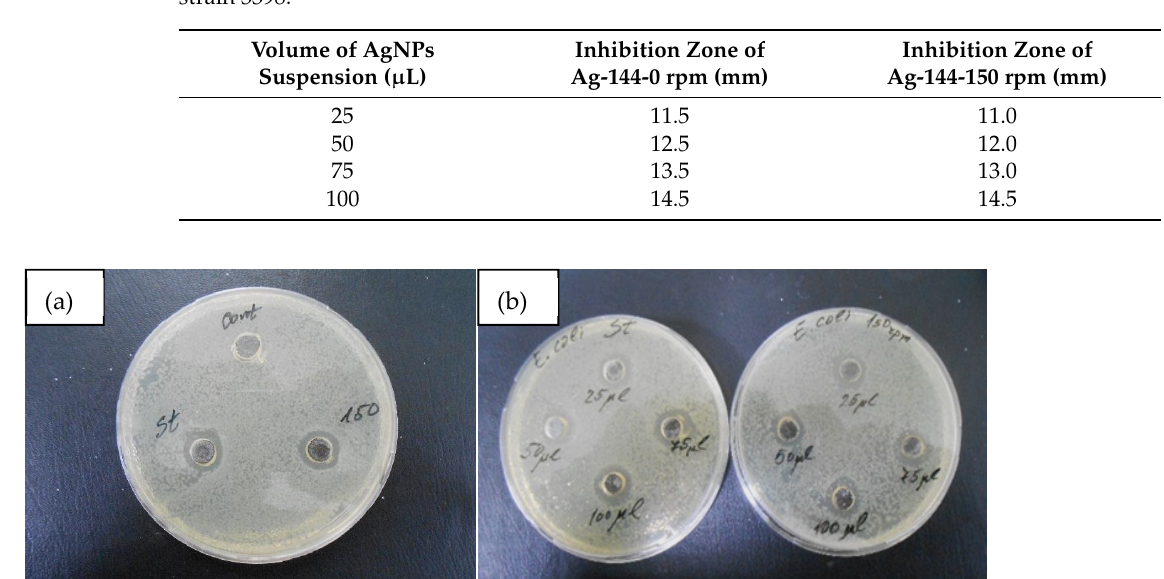
Table 4. Inhibition zones of the AgNPs (25, 50, 75 and 100 µ L suspensions) obtained by biotransfor- mation under static (Ag-144-0 rpm) and dynamic (Ag-144-150 rpm) conditions, with respect to E. coli strain 3398.